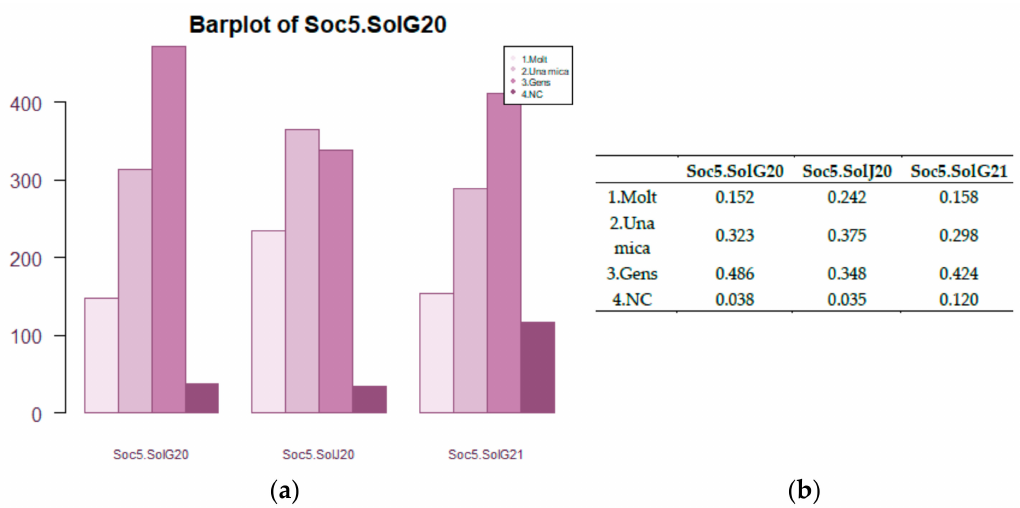
Figure 41. ( a ) Multiple bar plot of loneliness feelings ( b ) Proportions of Soc5.SolG20 per